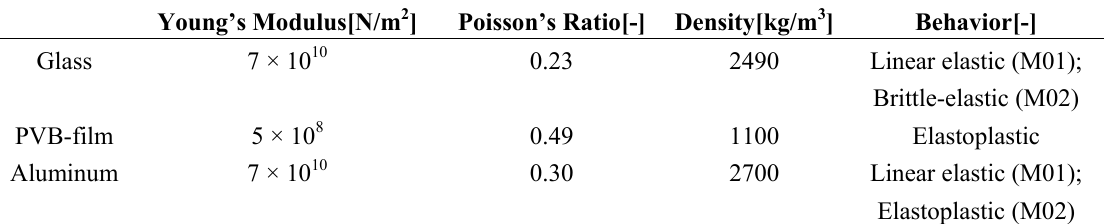
Table 1. Material properties for M01 and M02